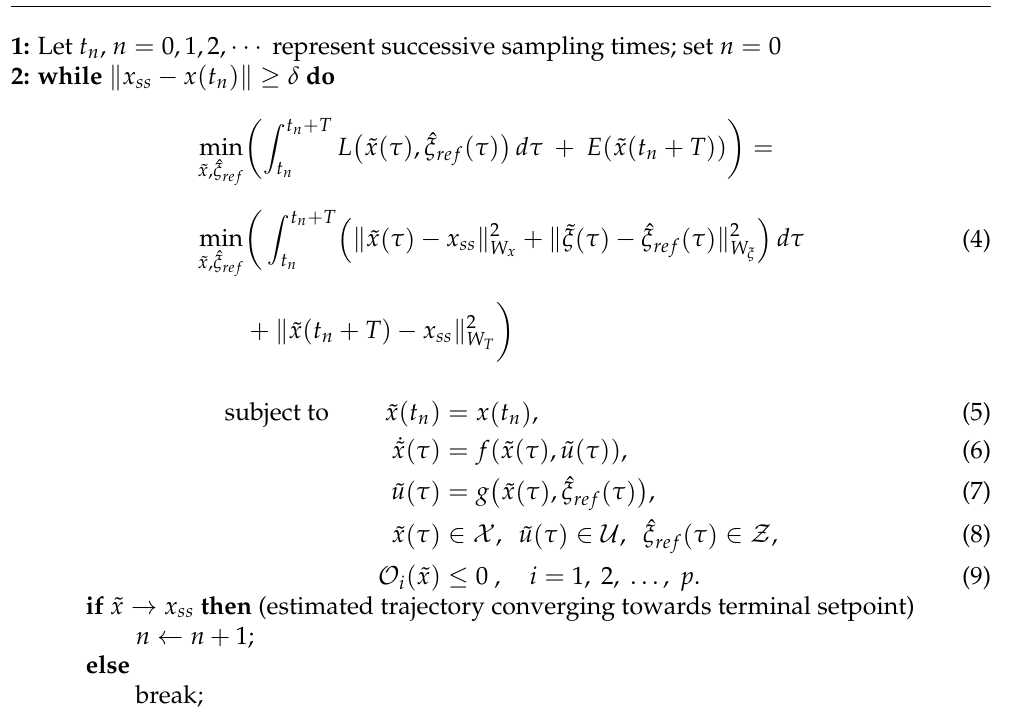
Algorithm 1 (NMPH algorithm with stabilizing terminal condition x ss